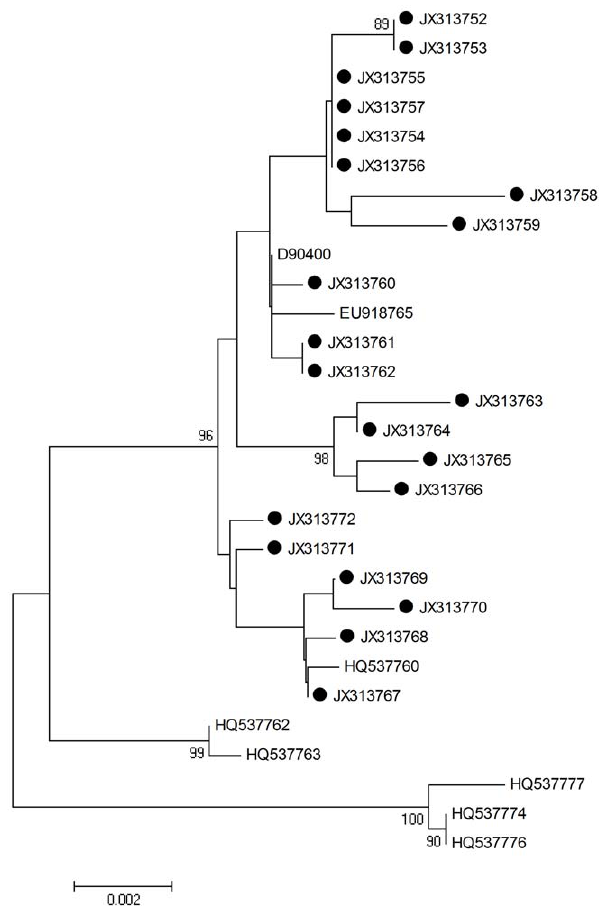
Figure 3. Neighbor joining phylogenetic tree generated using nucleotide sequences of the HPV-58 L1 gene. Study sequences are labeled in black. Others are standard sequences, including: D90400 (Japan), EU918765, HQ537760 (isolate AS347), HQ537762, HQ537763, HQ537776, HQ537774, and HQ537777. Phylogenetic trees were constructed by the Neighbor-Joining method and the Kimura